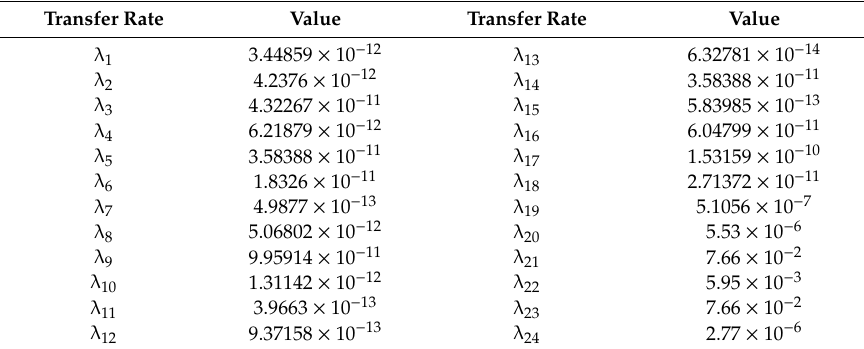
Table 7. The value of every transfer